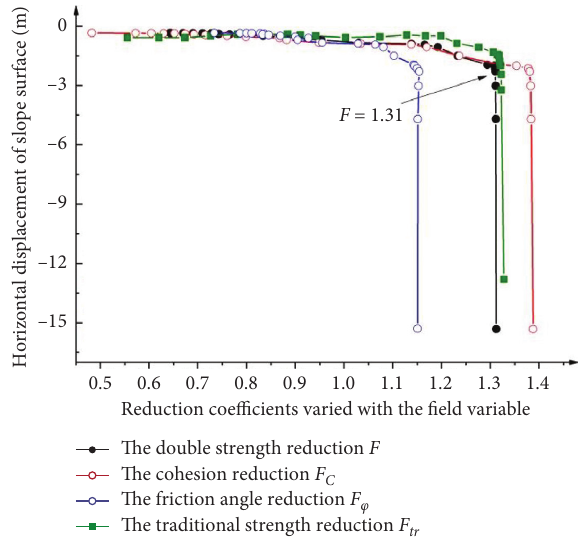
Figure 10: Horizontal displacement curve of the characteristic points on the slope under different reduction coefficients varied with the field variable.